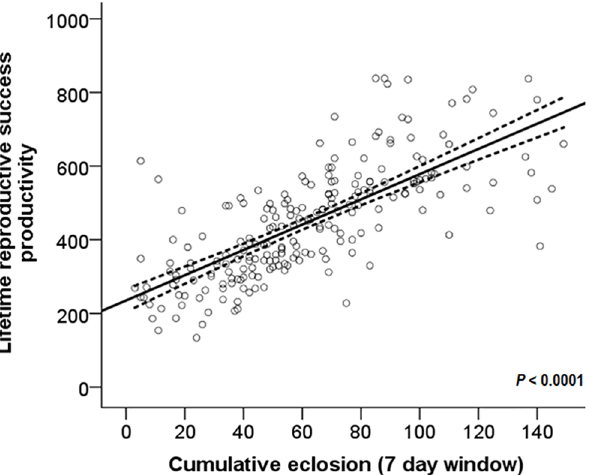
Fig 4. Regression of late short term reproductive output on lifetime reproductive success. Late short- term reproductive success was measured as the total number of offspring eclosing during a seven day window after females were approximately 30 days old. Dashed lines represent the 95% CI.